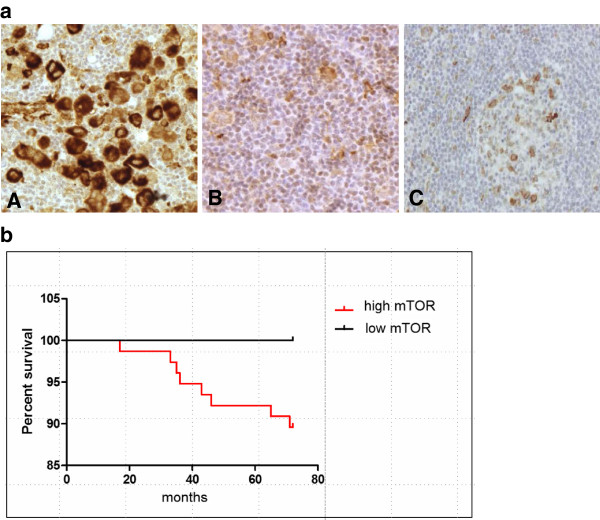
mTOR activity in human Hodgkin-lymphoma biopsies. a. High (A) and low (B) mTOR activity in lymphoma cells of Hodgkin-lymphoma biopsies. Low mTOR activity is comparable to that of reactive lymph nodes (C). (pS6 IHC; representative examples are shown.) b. Kaplan-Meier survival curves stratified by mTOR activity: low mTOR and high mTOR groups include 6 and 77 cases respectively (p=0.42).